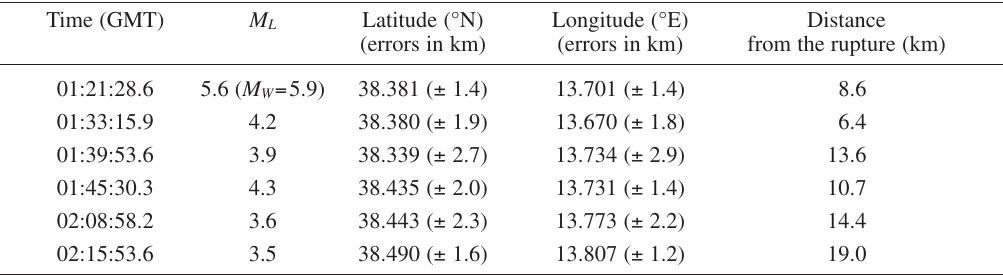
Table II. List of the major shocks ( M L ≥ 3.5) occurring on September 6, 2002 (INGV, 2005); the last column indicates the distance in km of each seismic event from the rupture in the fibre-optic cable. Time (GMT) M L Latitude